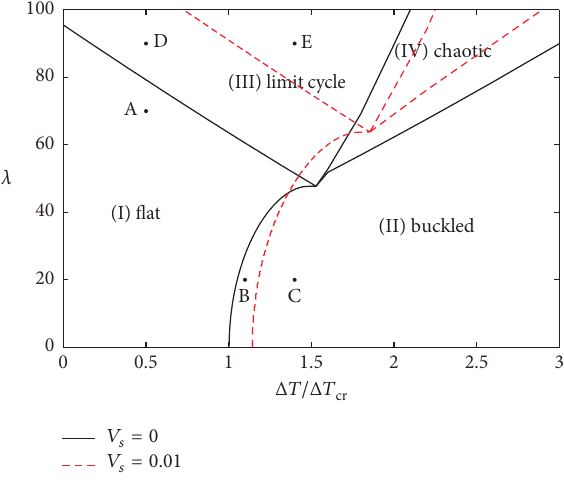
Figure 11: Time history for 𝜆 = 20 and Δ𝑇 = 1.1Δ𝑇 cr .